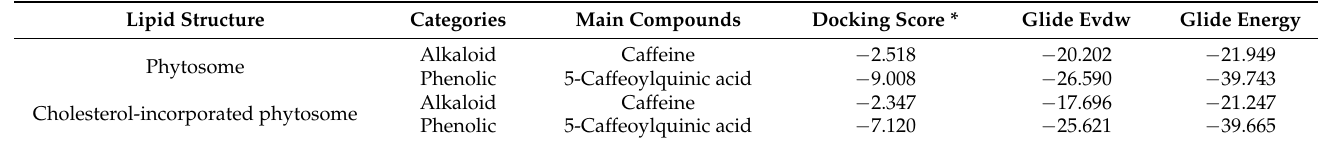
Figure 5. 3D model of lipid bilayers. ( a ) Bilayer containing phosphatidylcholine and cholesterol; ( b ) simulated model for bilayer designed with phosphatidylcholine. The polar site of the bilayer is fitted to the outer layer and covered with hundreds of water molecules (the white and red site on top and bottom of bilayer). Differences on bilayer diameter between structure ( a , b ) are discussed in Section 3.2.4. * Initial Lipid Coating * and Table 4). Table 7. Binding energy of docked molecule expressed as